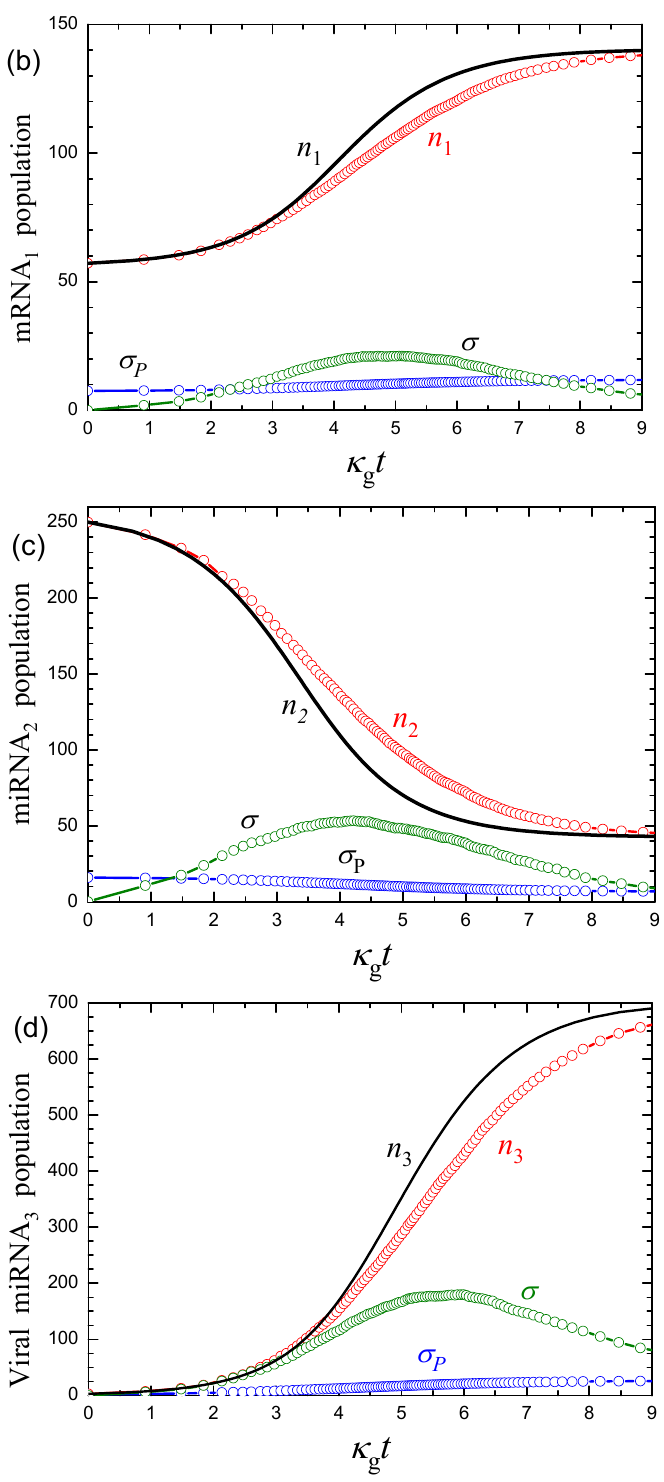
Figure 5. ( a ) G, ( b ) mRNA 1 , ( c ) miRNA 2 , and ( d ) miRNA 3 kinetics as a function of κ g t for n g ( 0 ) = 1. The mean-field populations (Equations (19) and (20)) are shown by solid lines. The averaged MC populations, standard deviations (Equation (21)), and Poissonian deviations (Equation (23)) shown by open circles were calculated by using 100 MC runs (as those exhibited in Figure